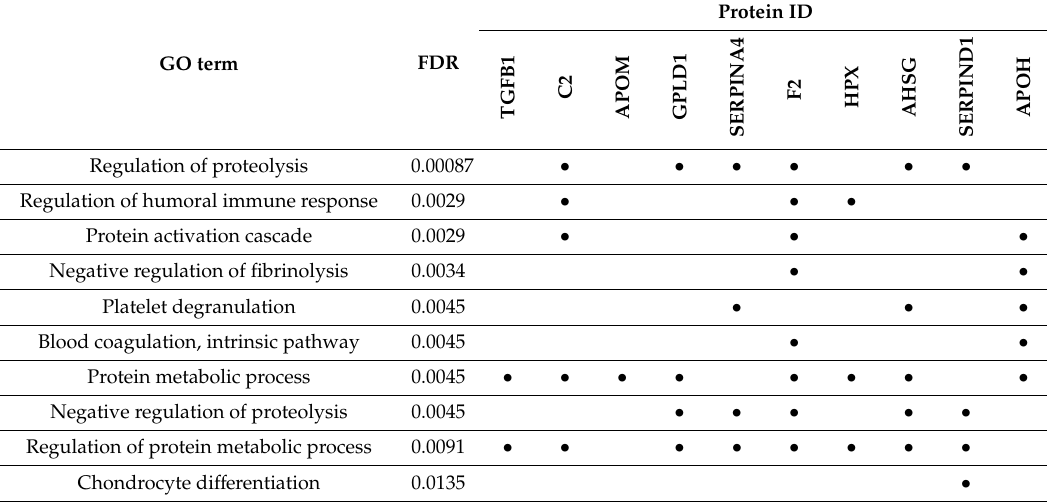
Table 5. Top 10 enriched Gene Ontology (GO) terms of up-regulated HDL proteins due to fish oil supplements.